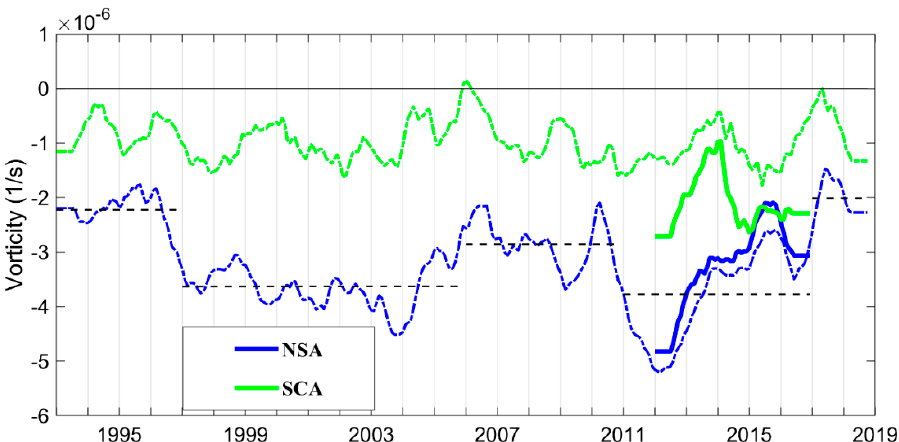
Figure 6. Time series of the spatially averaged, low pass filtered (13 month) vorticity field over the regions of the NSA and SCA. Dashed-dotted lines refer to the vorticity field derived from the AGV. The continuous lines are related to the vorticity field derived from optimal currents from 2012 to 2016. The dashed black lines show the average values of the vorticity over each anticyclonic/cyclonic period of the Northern Ionian Gyre.